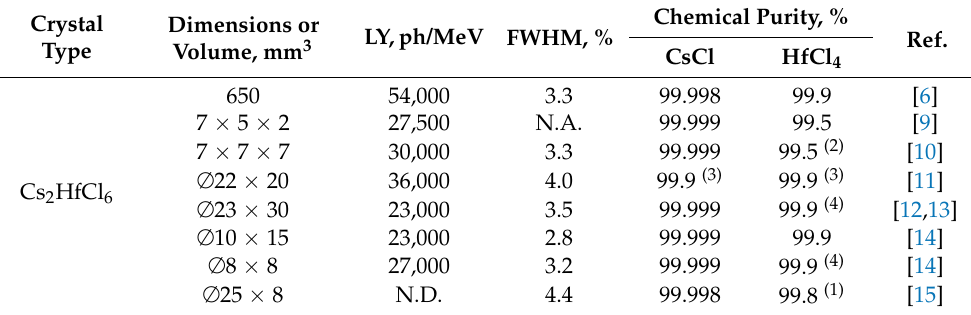
Table 1. List of recently produced Cs 2 HfCl 6 (CHC) crystals by different groups, crystal dimensions used for characterization (in case of cylindrical sample its diameter ( ∅ ) is also listed), the relative light yield (LY) and energy resolution (FWHM) measured under irradiation by 662 keV gamma line of 137 Cs source, and chemical purity of corresponding raw materials used for crystal growth. N.A. means “not